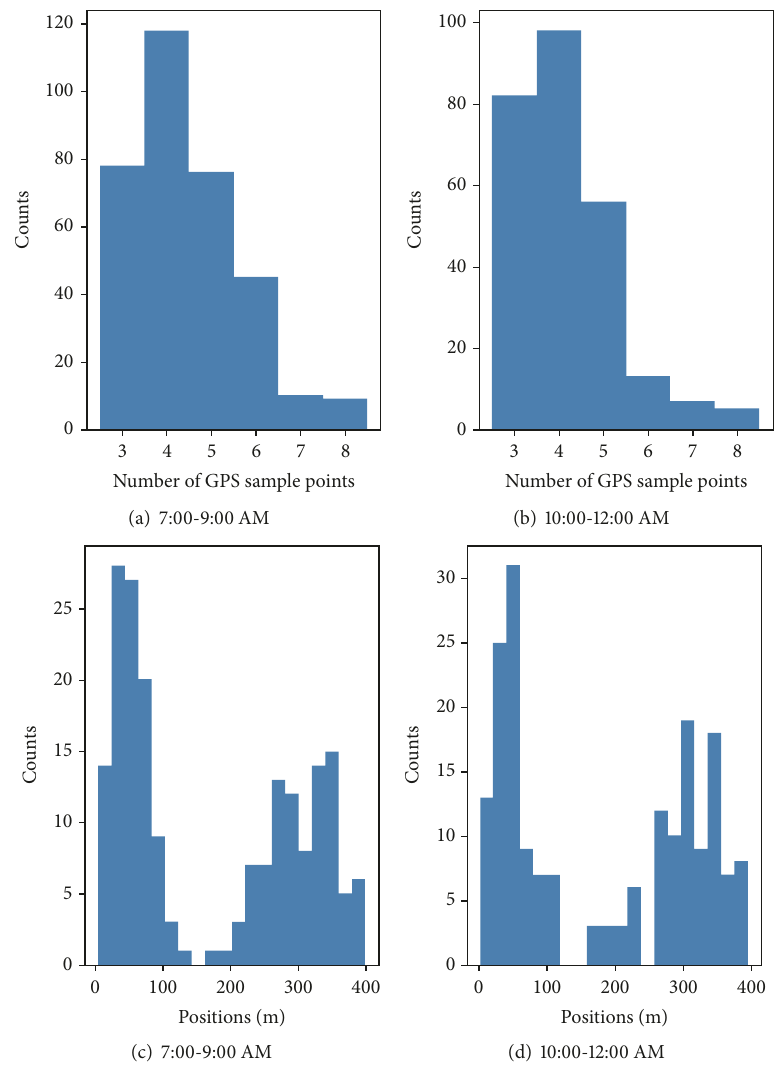
Figure 1: Histogram of GPS sample points and stop